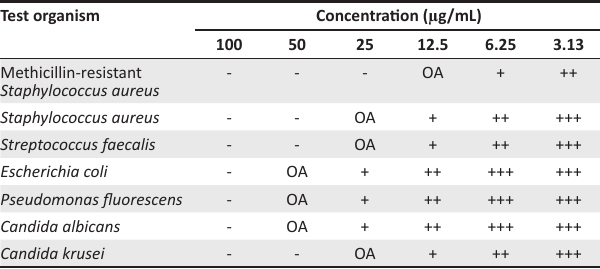
TABLE 3: Minimum bactericidal and fungicidal concentration of stigmasterol on the test organisms. Test